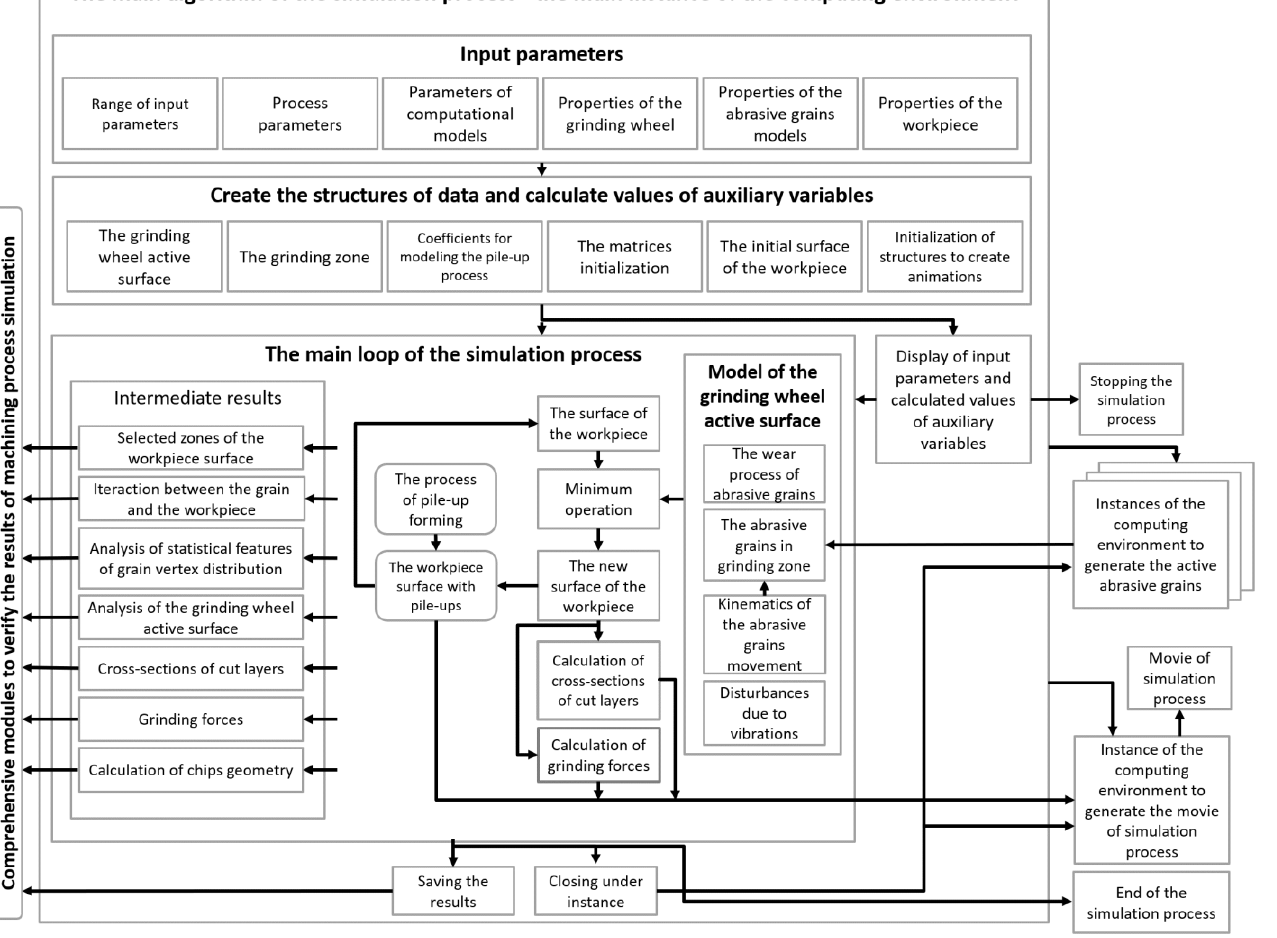
Figure 1. Schematic diagram of the structure of a comprehensive system for simulating the grinding process.